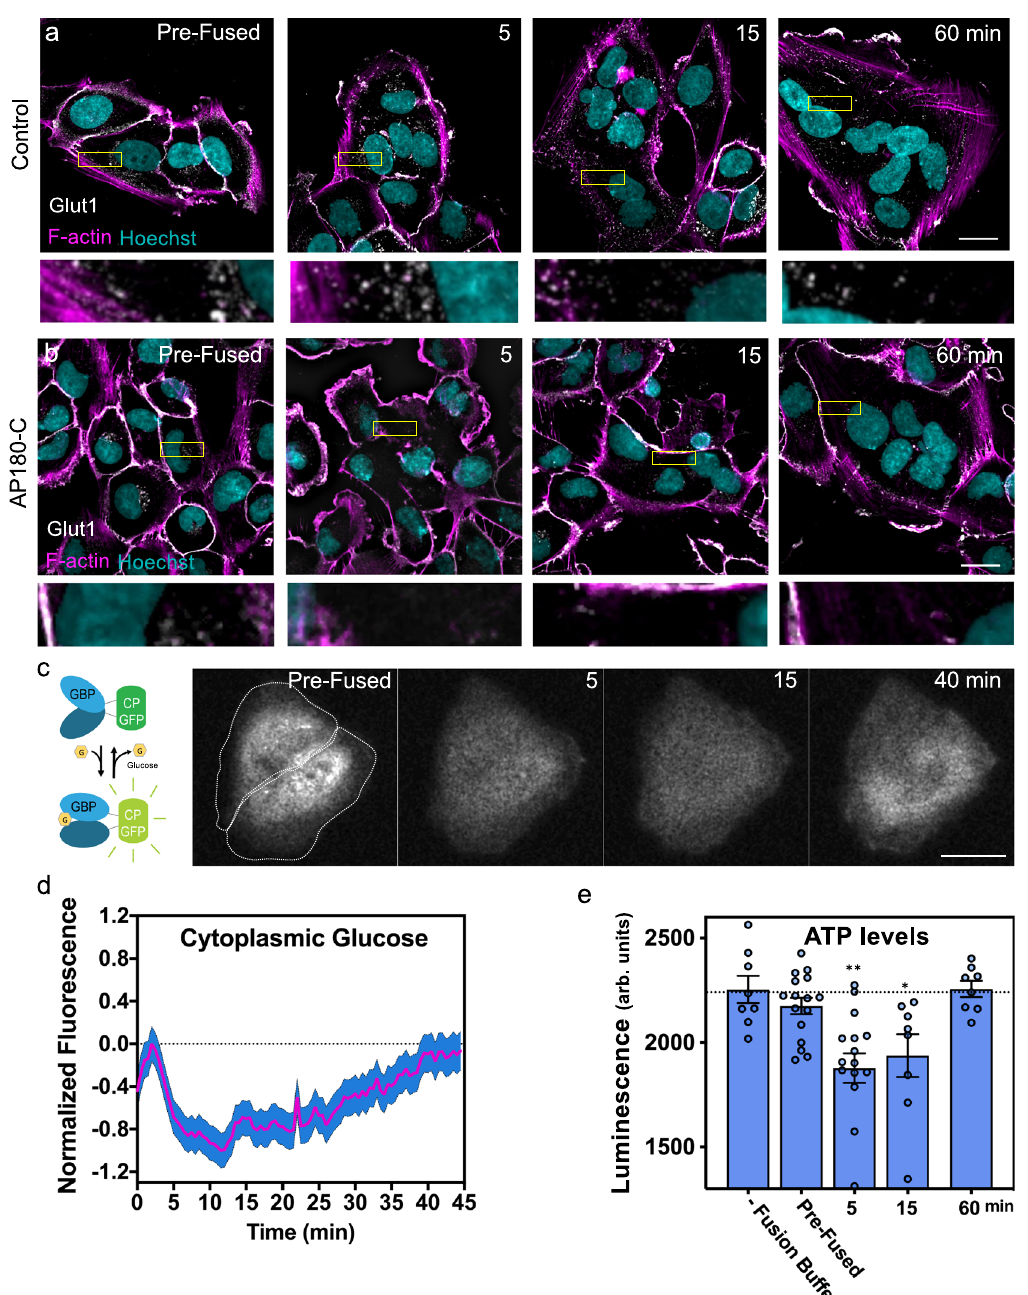
Fig. 6 Cell fusion leads to a reduced energy state through transient, CME-dependent glucose channel internalization. SUM-159 cells expressing VSV-G ( a ) or VSV-G and AP180-C ( b ) were induced to fused and then fi xed at indicated time points. Anti-Glut1 antibodies were used to assess the subcellular localization of Glut1 by confocal microscopy. Insets depict a region in the cytoplasm at each time point. Images in a and b are representative of three independent experiments. c The glucose biosensor, iGlucoSnFR.mRuby2 (depicted in left panel, GBP glucose binding protein) fl uoresces when glucose is bound. The intensity of the cytoplasmic biosensor fl uorescence was monitored as cells expressing VSV-G were induced to fuse. Images are representative of nine independent experiments. d Relative cytoplasmic glucose levels were measured overtime in fusing cells. To calculate the relative changes, the fl uorescence intensity in fusing cells was normalized to the intensity of control non-fusing cells. The blue area represent the SEM overtime, n = 19 cells. e VSV-G transfected SUM-159 cells were fi xed before fusion, or at the indicated time after fusion was induced. Relative cytoplasmic ATP levels were measured using a luciferase-based assay (arb. units; arbitrary units). Error bars represent the SEM, n = 8, n = 16, n = 16, n = 8, and n = 8 replicates examined over two independent experiments for unwashed pre-fused, and fused cells after 5, 15, and 60 min, respectively. p values represent the differences between the pre-fused cells and each time point (5 and 15 min). ** p = 0.0009, and * p = 0.0153. Statistical signi fi cance calculations were performed using a two-tailed unpaired Student ’ s t test. Scale bar size = 10 μ